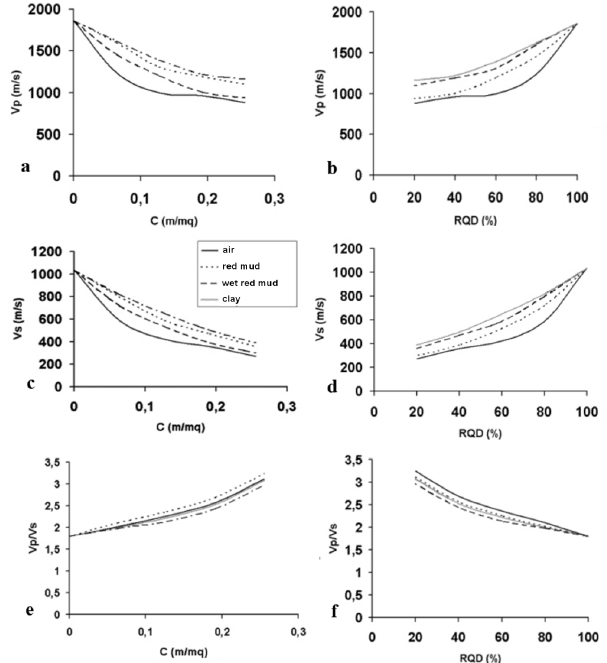
Fig. 1. Plots of (a) Vp versus density of fracturing C, (b) Vp ver- sus quality factor RQD, (c) Vs versus density of fracturing C, (d) Vs versus quality factor RQD, (e) ratio Vp/Vs versus density of fractur- ing C, (f) ratio Vp/Vs versus quality factor RQD. Note that y-axes are not in scale. Modified after Leucci and De Giorgi